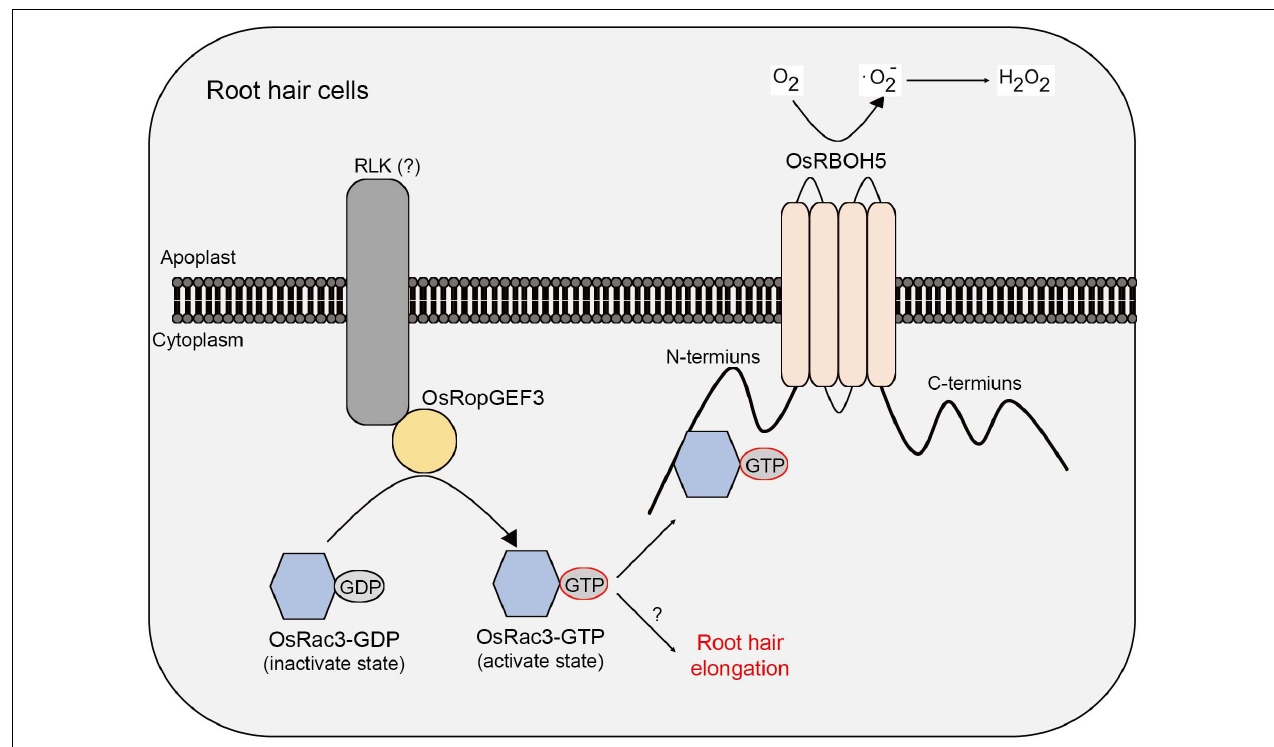
FIGURE 8 | Models of OsRopGEF, OsRac, and OsRBOH proteins inside the rice root hair cells. Based on the PM, the upper part is the apoplast and the lower part is the cytoplasm. OsRopGEF3 localizes to the PM. However, since OsRopGEF3 does not have a transmembrane domain, it is expected to interact with RLK using the PRONE domain. OsRopGEF3 interacts with OsRac3 near the PM to change GDP to GTP. OsRac3-GTP was bound to the N-terminal of OsRBOH5 and resulted in ROS generation in the apoplast. Furthermore, OsRac3 can regulate root hair elongation. However, the specific pathway remains unknown.